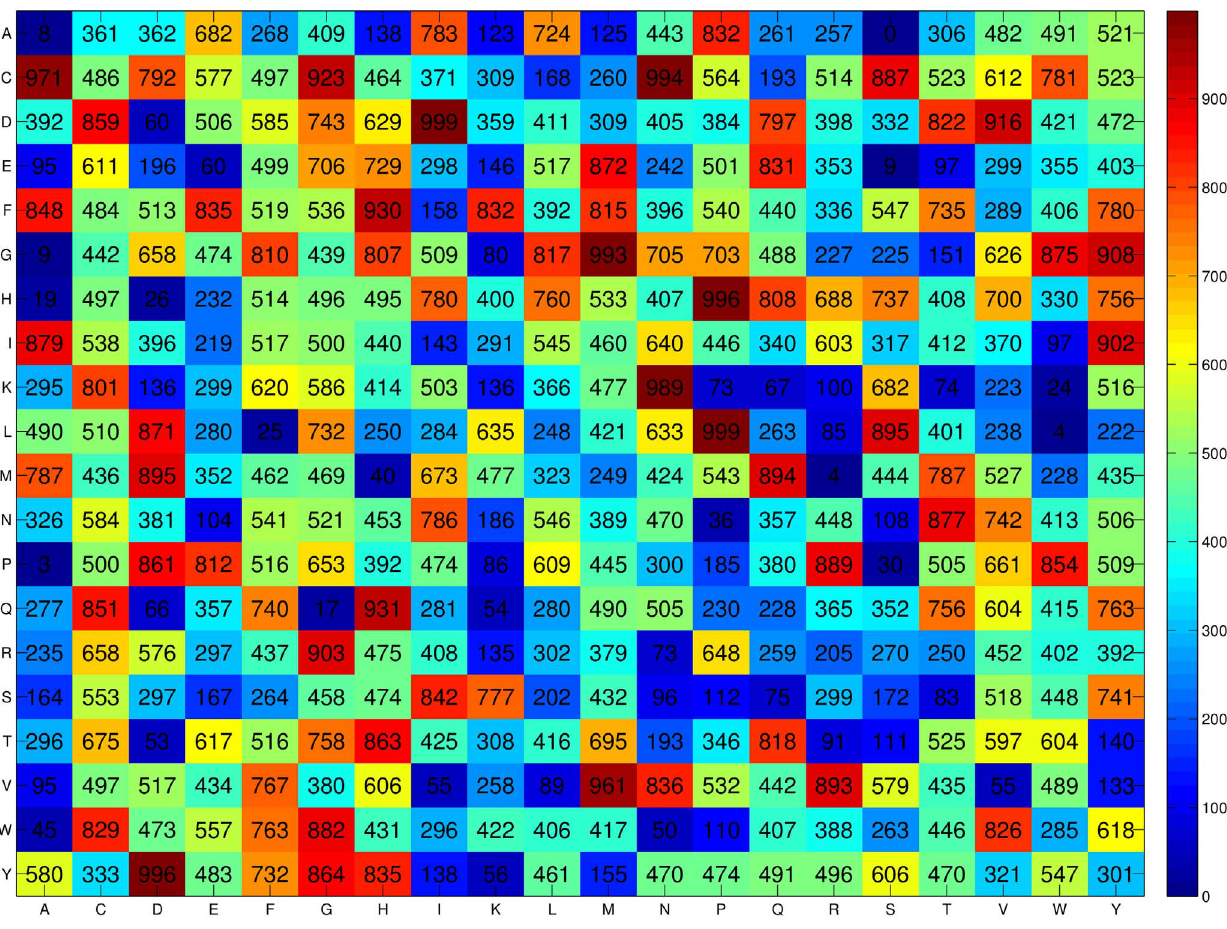
Figure 2. Heat map of the propensity scores of 400 dipeptides obtained from the SCMBLP method. Color bar is obtained using Jet of Matlab.